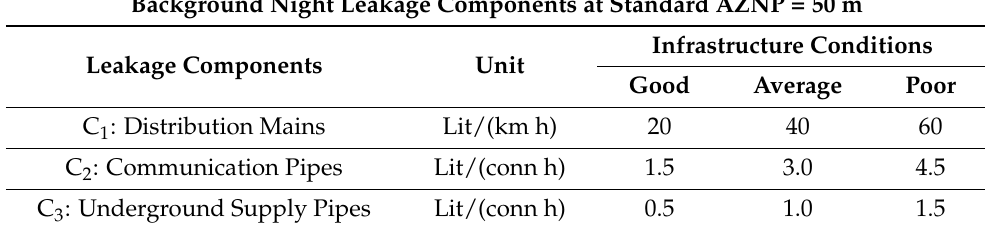
Table 2. Background Night Leakage component used for leakage calculation